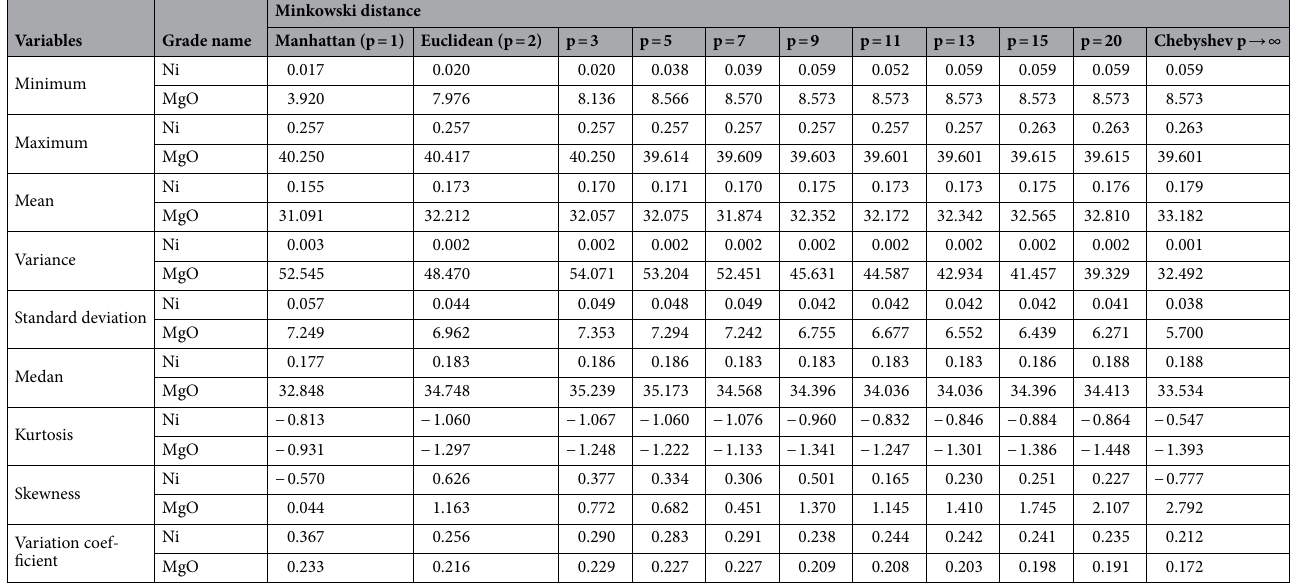
Table 2. Estimation grade statistics of model